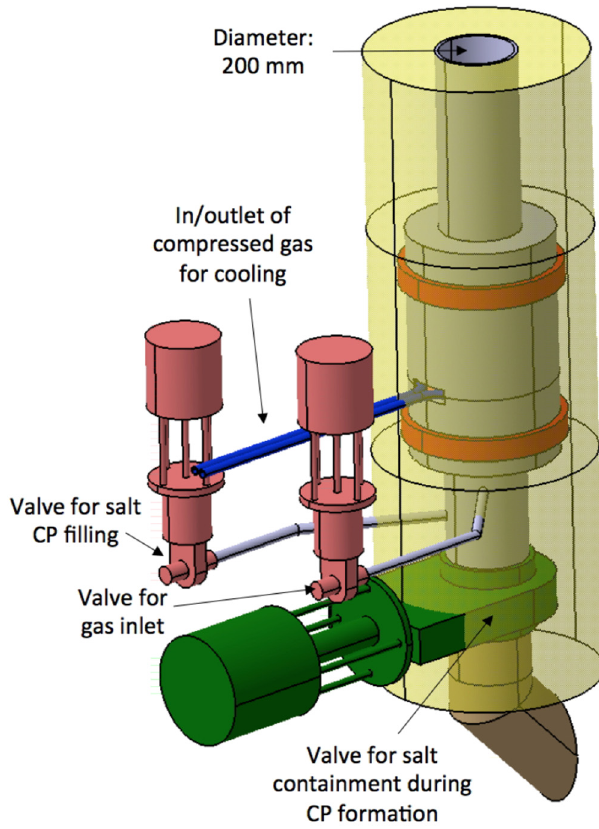
Fig. 15. Main required components of a reactor cold